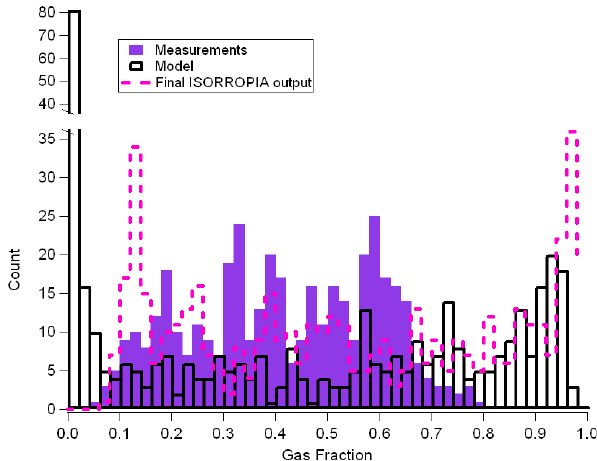
Fig. 10. Histogram of the measured and modelled gas fraction from Figure 8, now including the result of final offline run of ISOR- ROPIA, iterated until the aerosol was fully neutralized and the gas phase concentration was equal to a pre-determined compensation